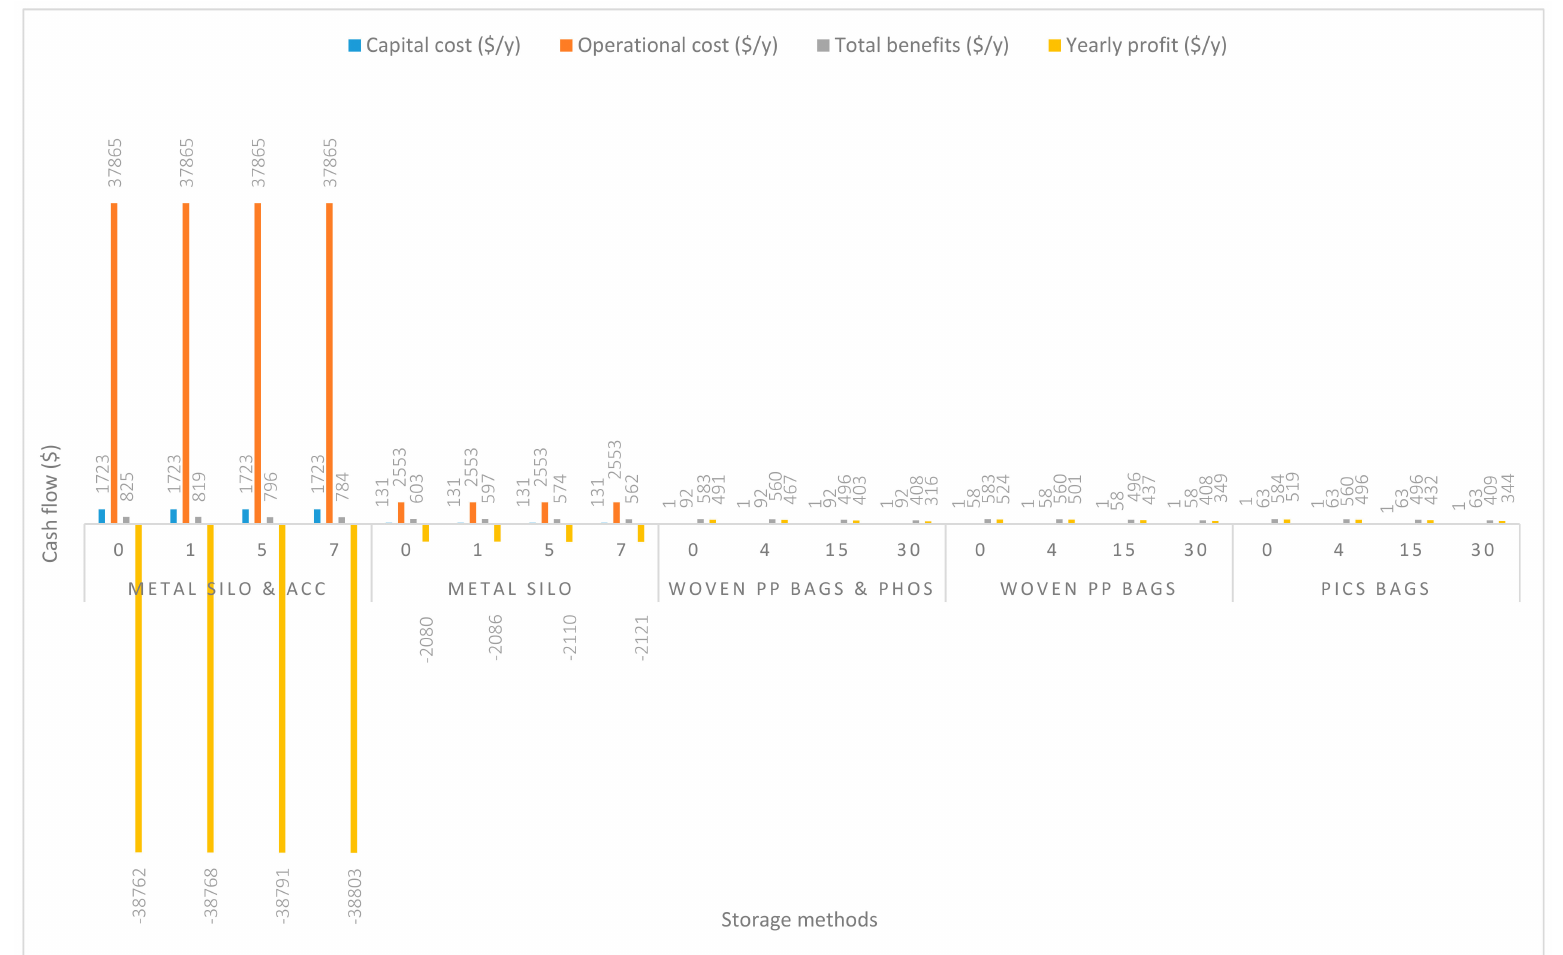
Figure 5. Annual capital and operational costs (US dollars), total annual benefits and profits (US dollars) for each handling / storage method at 2.8 Mg / y handling capacity for 0% to 7%, and 0% to 30% grain quantity